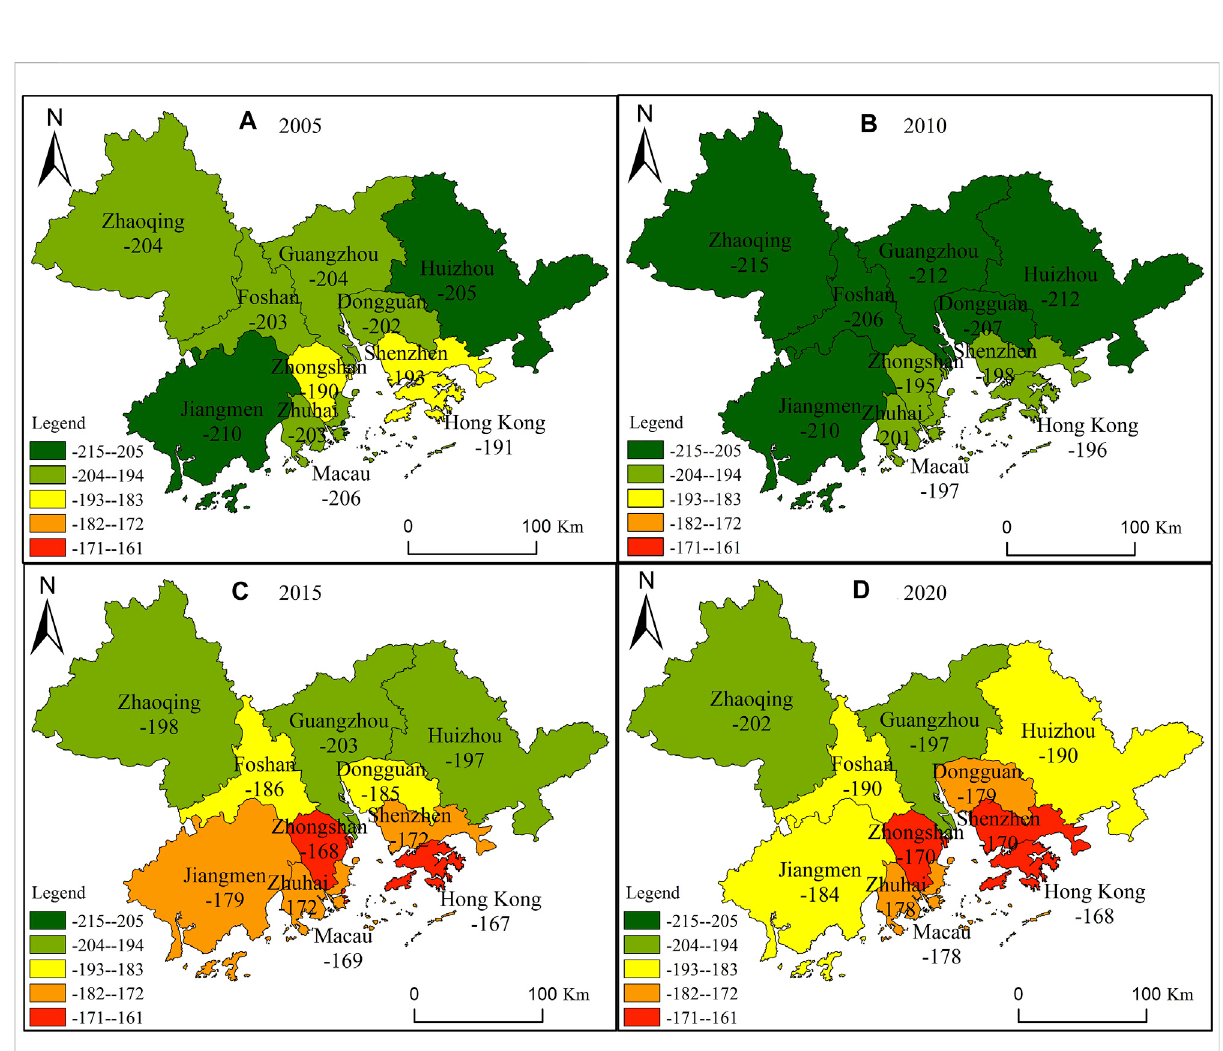
FIGURE 5 Annual change of wind ef fi ciency index in Guangdong – Hong Kong – Macau Greater Bay Area in 2005, 2010, 2015, and 2020. Seasonal and monthly evolution characteristics of climate comfort of human-settlement